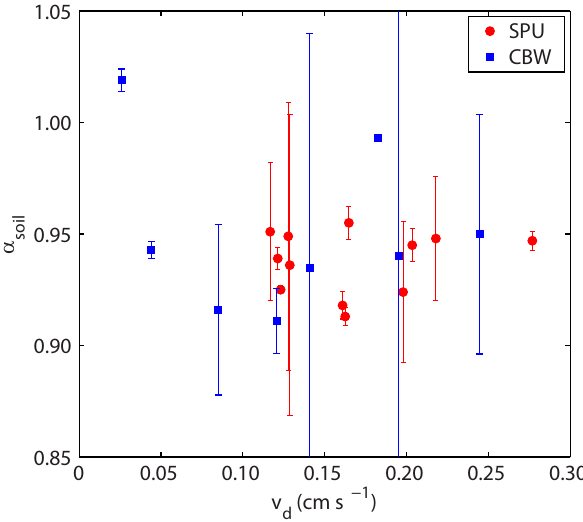
Figure 8. Correlation between α soil and v d for all Speuld exper- iments and Cabauw net-uptake experiments. The errors for α soil were taken from Table 1.